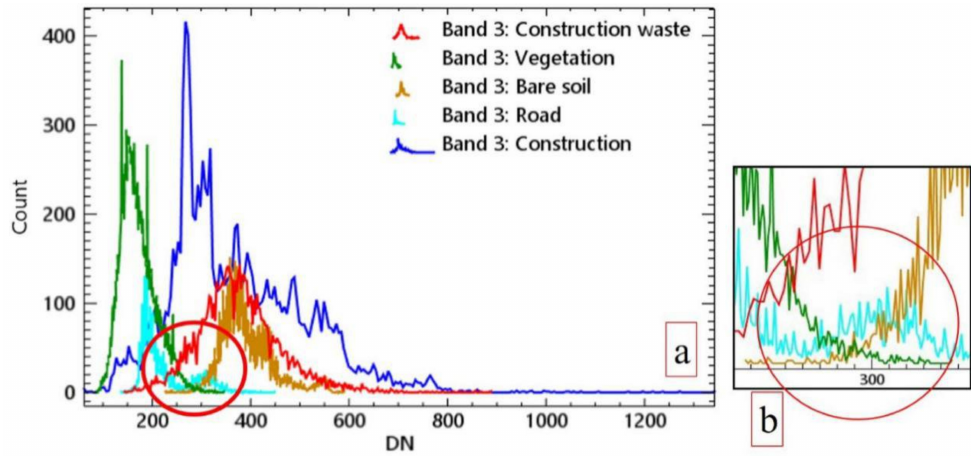
Figure 4. Histogram distribution of the third band in case A: ( a ) the junction of the vegetation road and the construction waste; ( b ) the approximate distribution range of the separated vegetation, road and other ground objects is